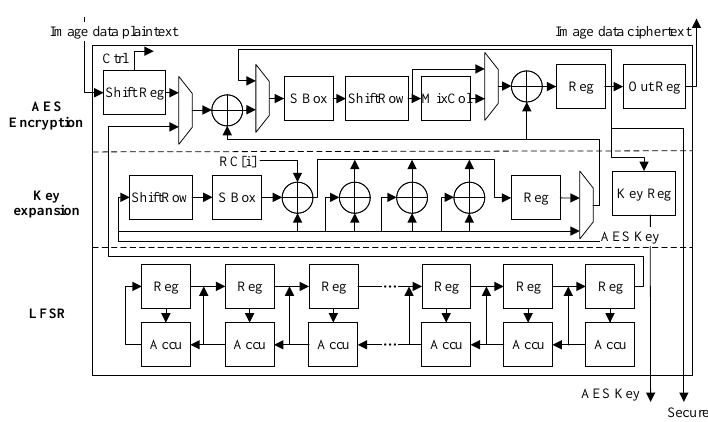
Figure 13. AES module structure.